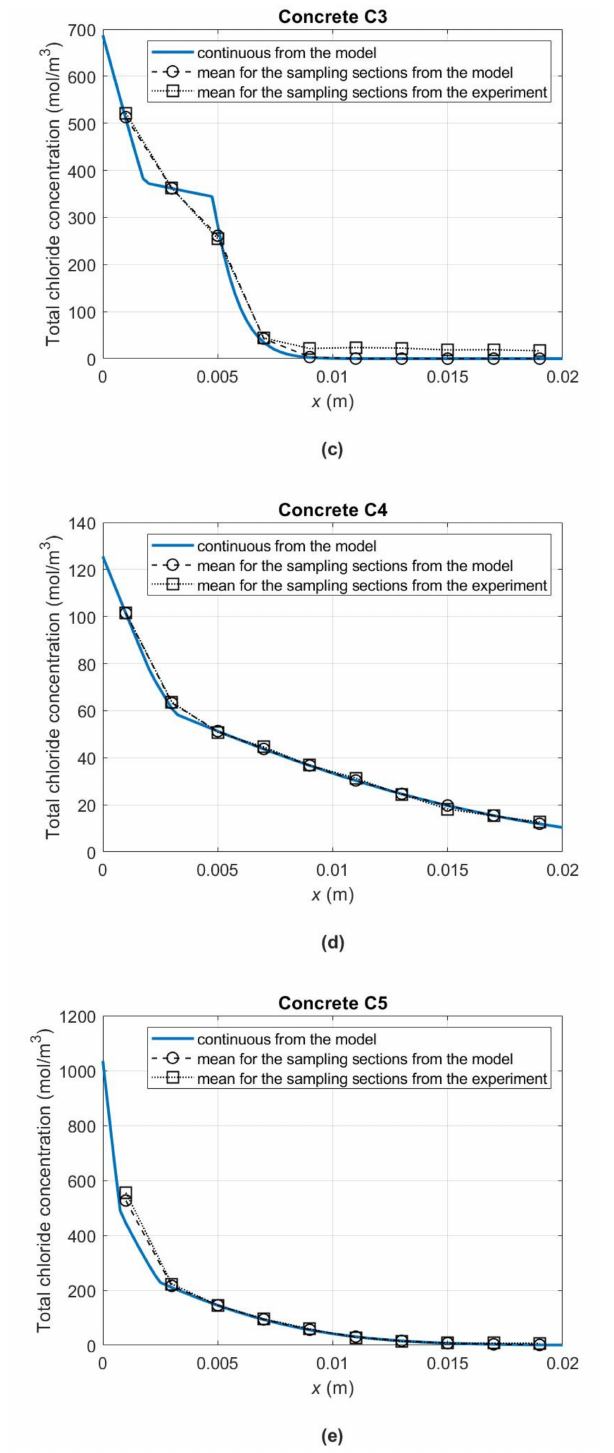
Figure 6. Mean concentrations of total chlorides after 180 days of diffusion in the samples’ successive layers with a thickness of 2 mm determined experimentally ( C t exp ) and calculated according to the model ( C t model ) with use of the material parameters presented in Table 5 for concrete C1 and Table 7 for concretes C2–C5. In the background, the continuous curves C t are also shown, on the basis of which the values of C t model were calculated. Concretes: ( a ) C1, ( b ) C2, ( c ) C3, ( d ) C4, and ( e ) C5. Coordinate x = 0 relates to the specimen external surface exposed to chloride solution exposed to the chloride